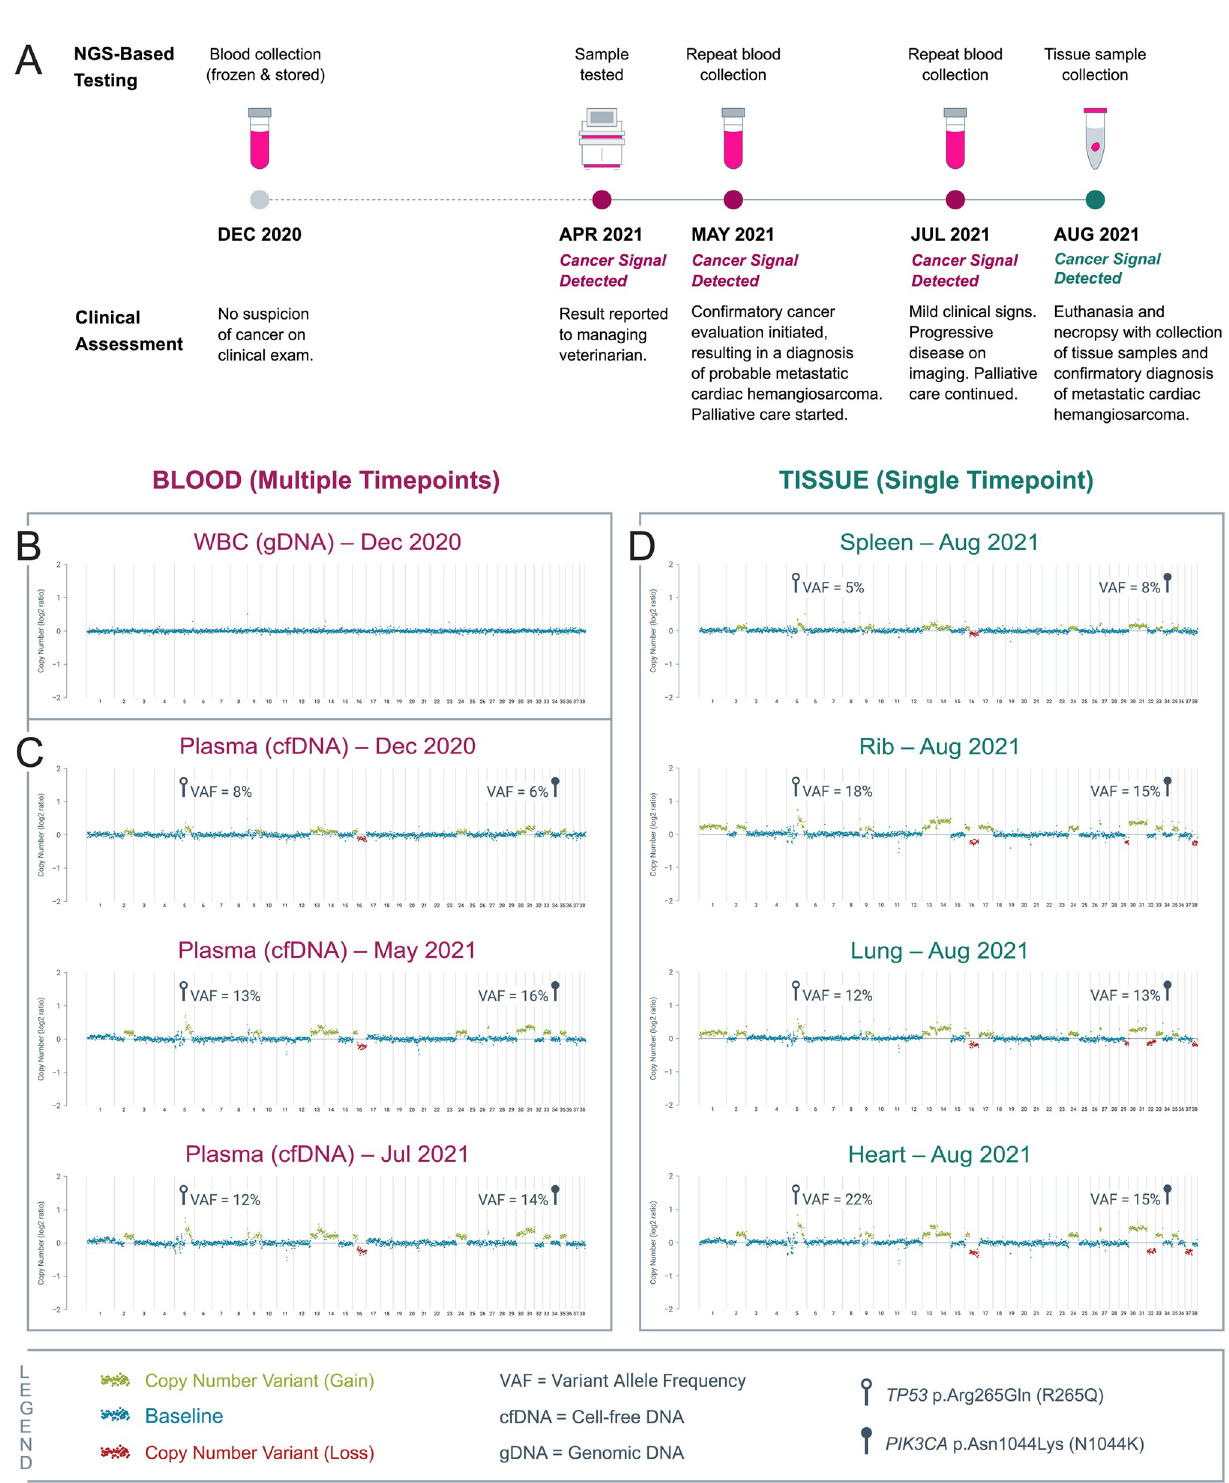
Fig 4. Case study of a presumably cancer-free 7-year-old, 37 kg female spayed mixed-breed dog that received a Cancer Signal Detected result and was subsequently diagnosed with hemangiosarcoma. (A) Timeline of NGS-based testing of blood and tissue samples, and the corresponding clinical assessments for the subject. (B) Sequencing data showing no genomic alterations in gDNA derived from white blood cells. (C) Sequencing data showing genomic alterations present in cfDNA from plasma samples obtained at multiple timepoints. (D) Sequencing data showing genomic alterations present in various tissue samples collected during